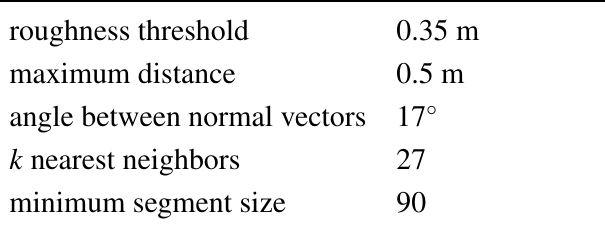
Table 2. Applied settings for roof plane